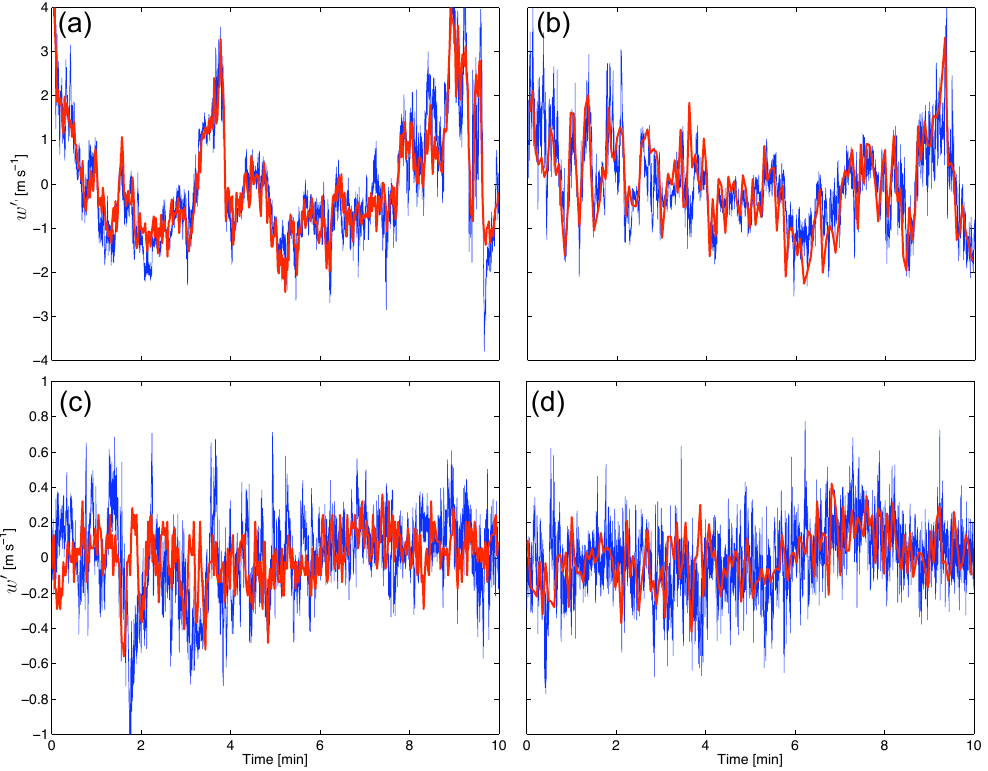
Figure 7. Time series of w (cid:48) during unstable (a, b) and stable (c, d) conditions, with each stability being the same during 10min time periods when the sonic anemometer is not waked by the 300m tower. OU DL data are at 300m (a, c) , and LLNL WC measurements are at 100m (b, d) . Red line shows the DL time series, while the blue line shows the comparable time series from the collocated sonic at the same height. Note that y axis scales for w (cid:48) are different in the top and bottom